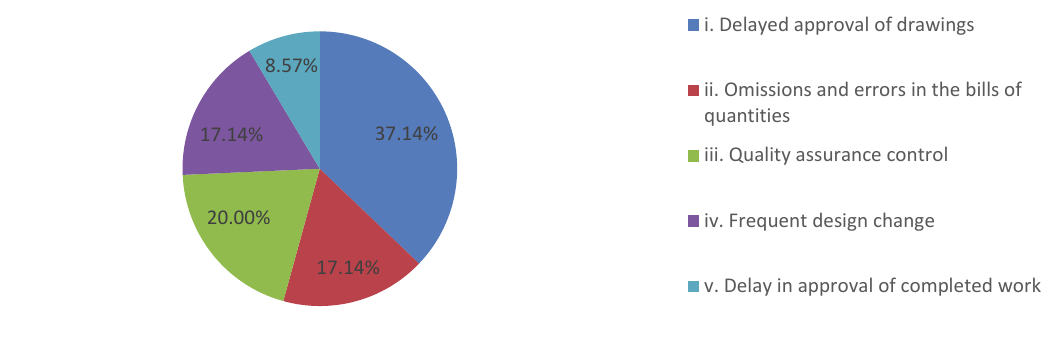
Fig. 4. Consultant related